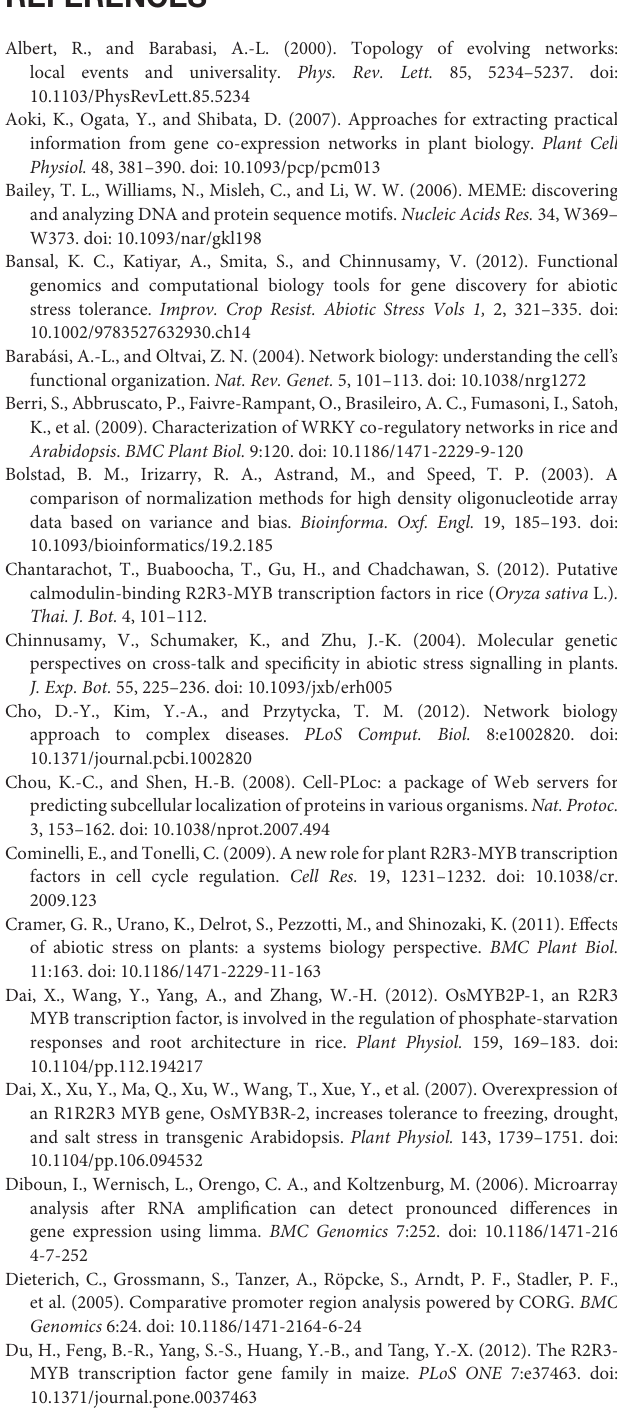
Table S8 | (A)List of cis- elements in 1kb upstream promoter region of direct first neighbor of guide OsMYB genes in global